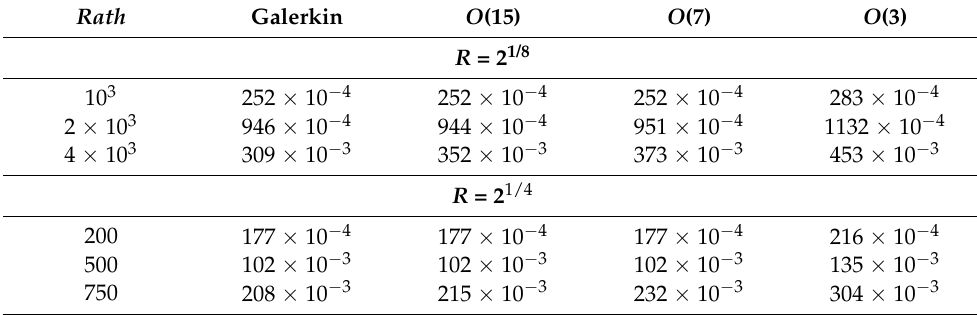
Table 1. Average Nusselt number ( Nu g − 1) for different values of Rath and R. Rath Galerkin O